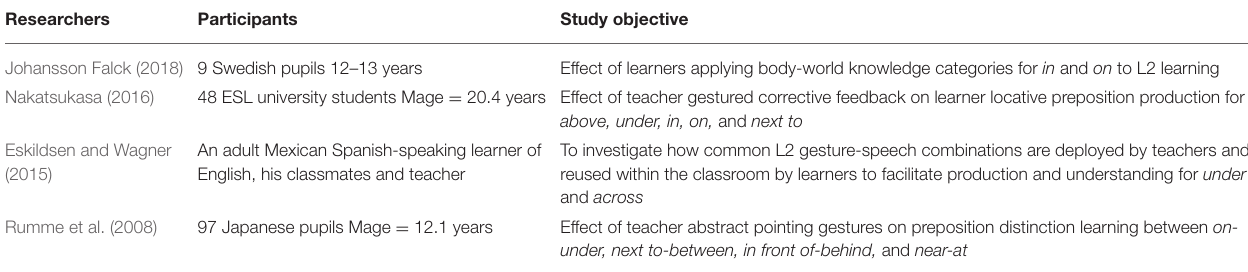
TABLE 1 | Previous studies involving gesture and spatial relations from english language classroom settings.